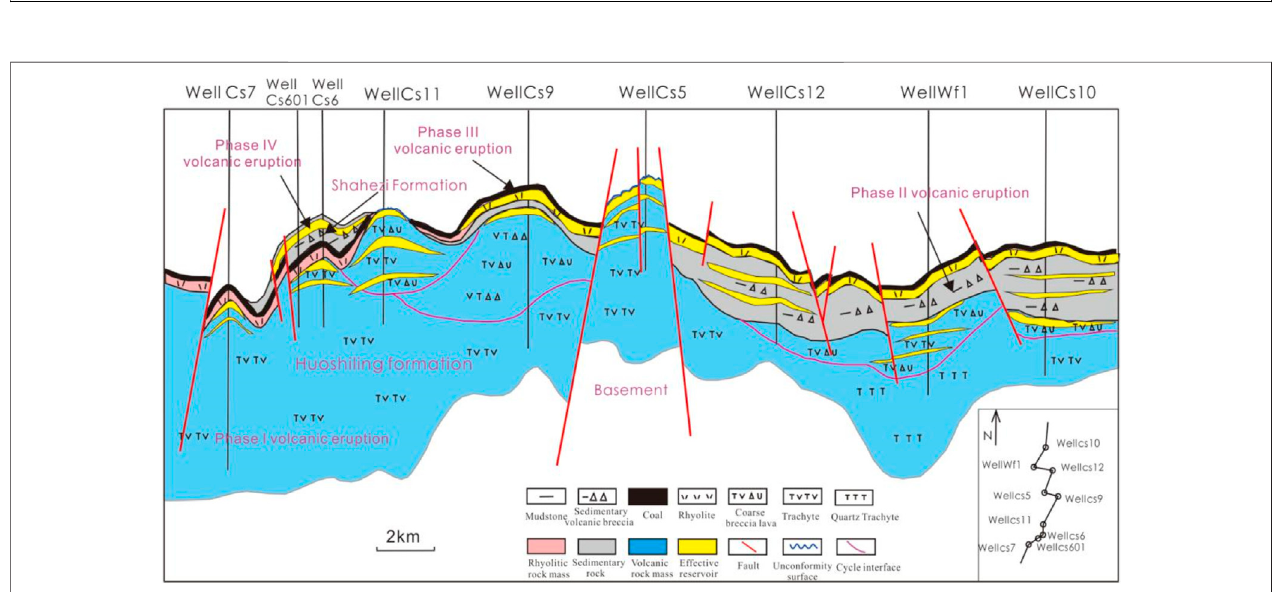
FIGURE 2 | Contrastive pro fi le of volcanic rocks in the Wangfu gas fi eld through wellCs7 to wellCs10.